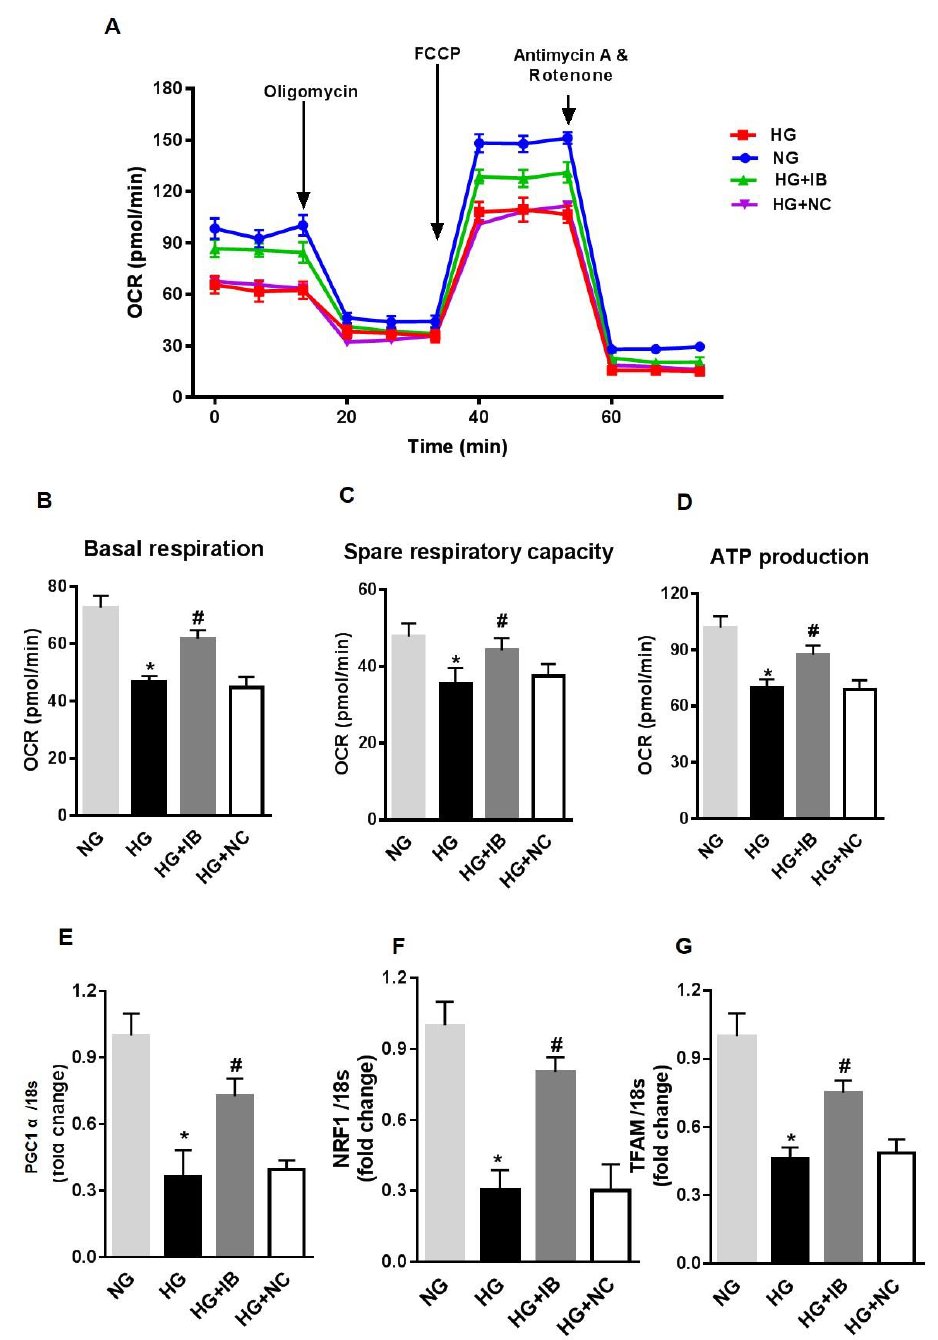
Figure 5. MiR-34a inhibition rescues high glucose-induced changes in mitochondrial respiration and biogenesis in HuREC. Mitochondrial function was assessed using the Seahorse XFp analyzer in HuREC transfected with 50 nM of miR-34a inhibitor (IB) or negative control (NC) for 24 h and exposed to high glucose (HG; 25 mM d -glucose) for 48 h. ( A ) oxygen consumption rate (OCR), ( B ), baseline, ( C ) spare respiratory capacity, and ( D ) ATP production are shown. ( E – G ) qPCR analysis assessing mRNA levels of genes regulating mitochondrial biogenesis: PGC-1 α , NRF-1, and TFAM. Bar histogram representing mRNA levels of ( E ) NRF-1, ( F ) PGC-1 α , and ( G ) TFAM genes in HuREC treated with NG (light gray bar) or HG (black bar) following without transfection or transfected with miR-34a IB (dark gray bar) and negative control (white bar). Bars represent mean value ± S.E.M; * p < 0.05 vs . NG and # p < 0.05 vs . HG, n = 4.